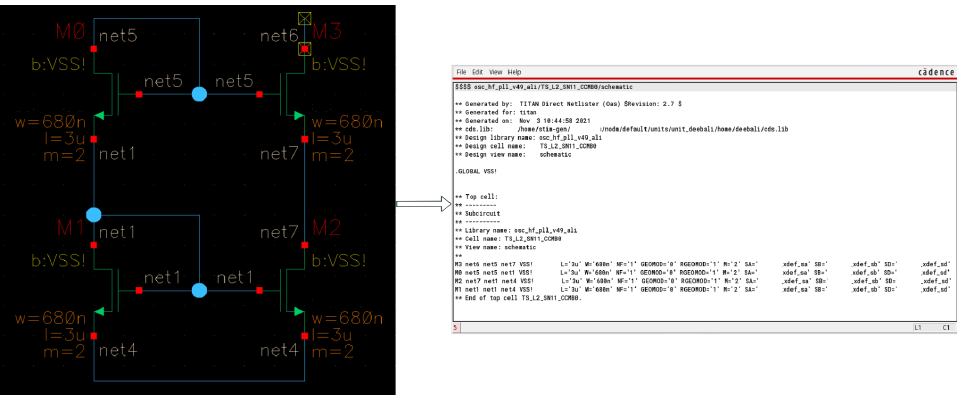
Figure 7. Dataset Transformation: Converting schematics to netlists using Cadence Virtuoso. The con- nectivity of the transistors is described after each transistor name in text form, followed by the electrical description and characterization of each